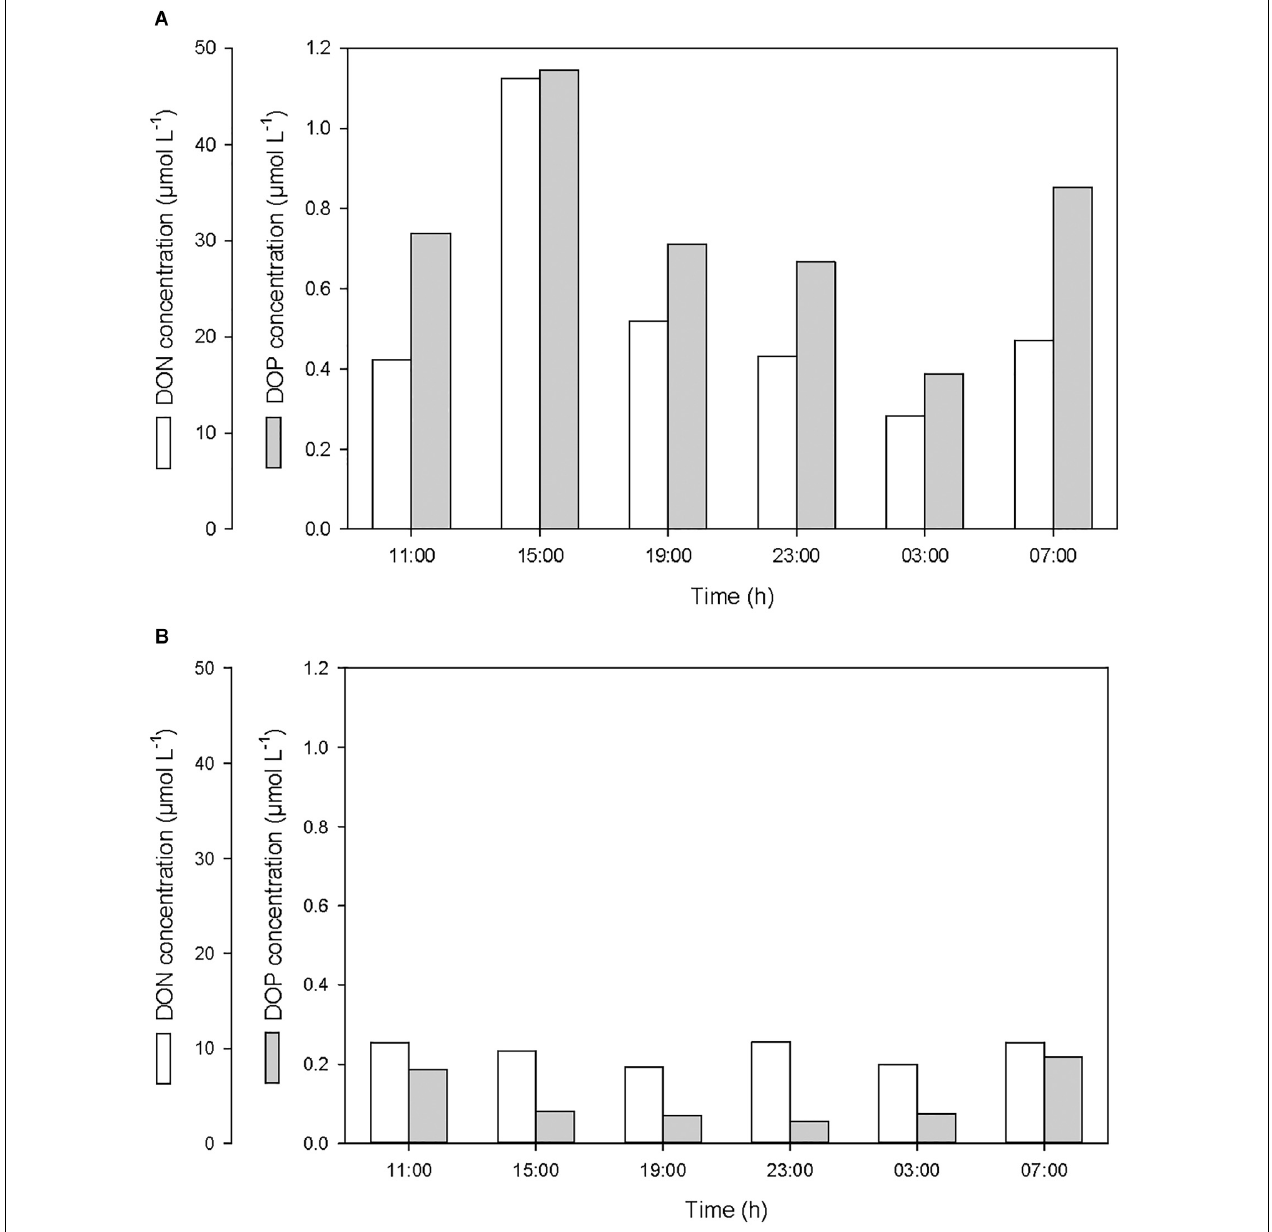
FIGURE 7 | Variations of dissolved organic nitrogen (DON) and phosphorus (DOP) concentrations (A) in the SML and (B) in the